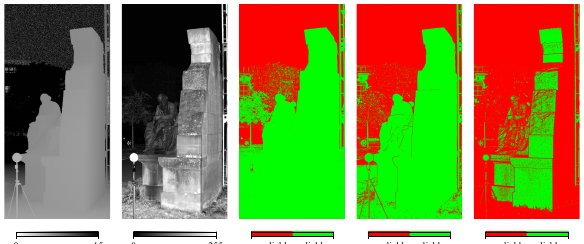
Figure 3. Range image, intensity image and the derived binary confidence maps based on intensity, range reliability and pla- narity (from left to